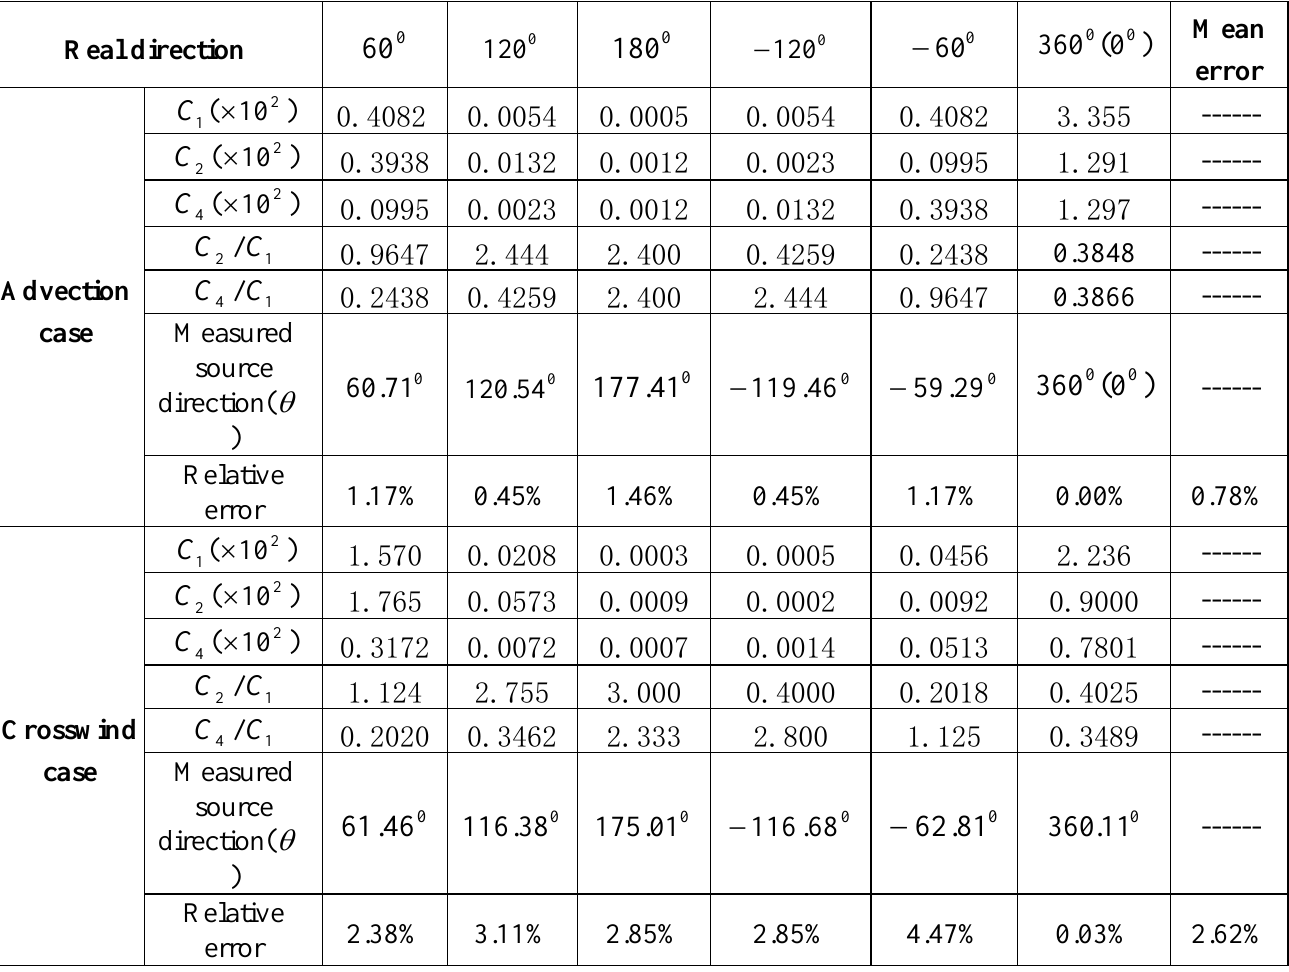
Table 1. Simulation result and errors for static